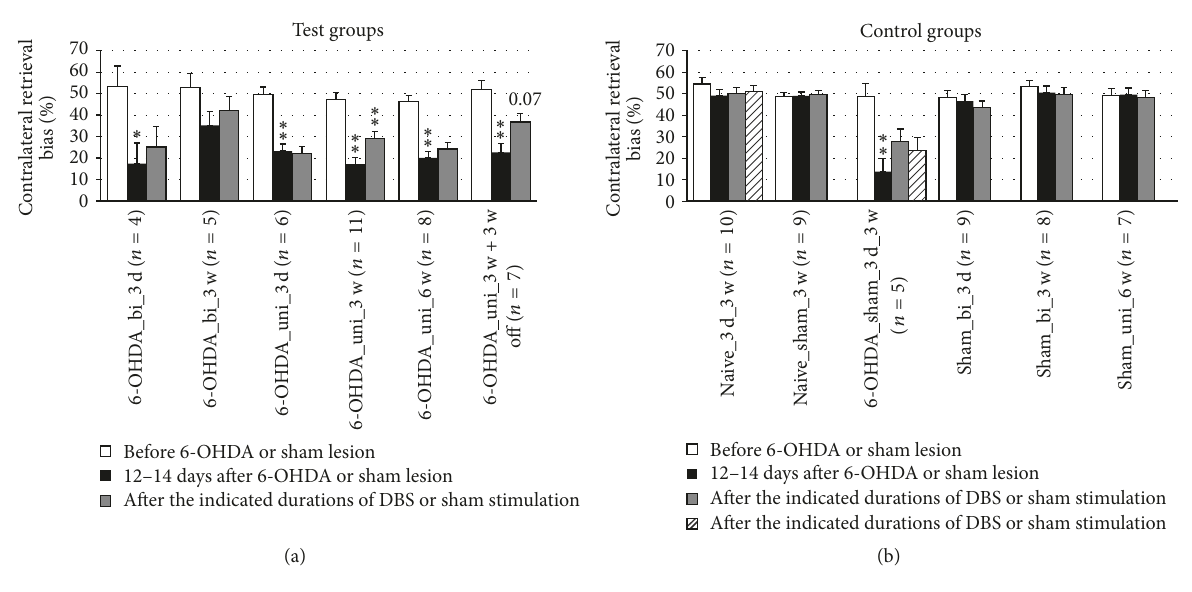
Figure 10: Short-term and long-term effects of DBS with uni- and bipolar electrodes on the sensorimotor neglect of hemiparkinsonian rats as measured by the corridor test. (a) and (b) refer to test groups and controls, respectively. Different column patterns indicate different times of behavioral testing; white: before 6-OHDA or sham lesion; black: 12–14 days after 6-OHDA or sham lesion; gray and hatched: after the durations of DBS or sham stimulation indicated in the group labels. For experimental details see Table 1. Significance levels are indicated with asterisks as follows: ∗∗ 𝑝 ≤ 0.01 , ∗ 𝑝 ≤ 0.05 , b (borderline): 0.05 < 𝑝 ≤ 0.08 according to one-way ANOVA. Asterisks above black columns refer to white columns; all others refer to black columns.